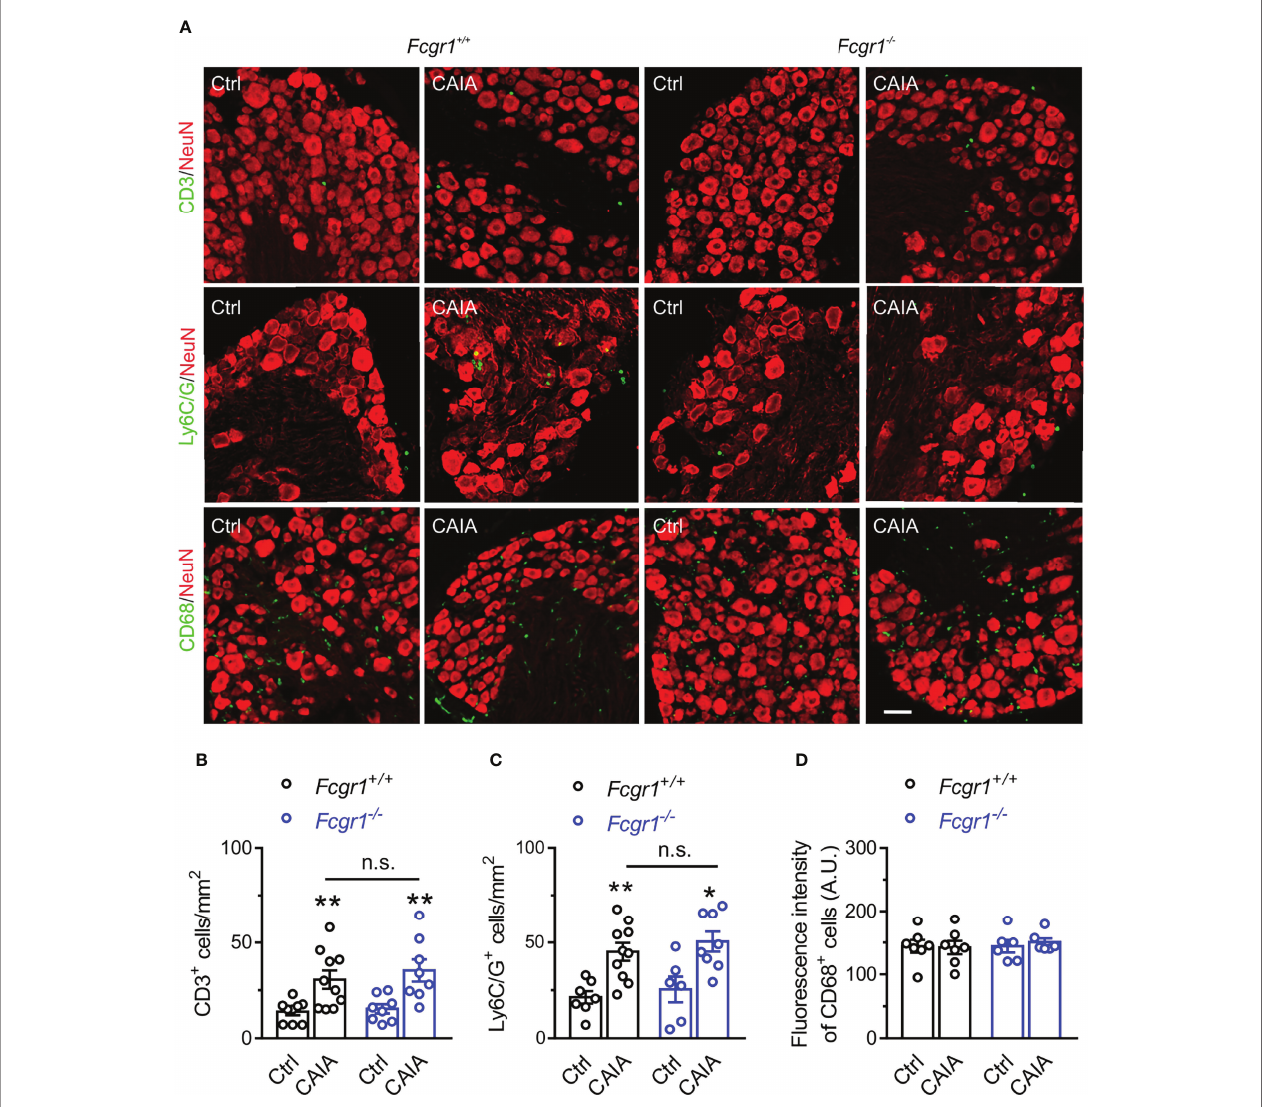
FIGURE 7 | Fc g RI does not contribute to immune cell in fi ltration in mouse DRG in the late phase of CAIA. (A) Representative image of mouse DRG sections from Fcgr1 +/+ and Fcgr1 -/- mice on day 56 after CAIA. DRG sections were stained for CD3, Ly6C/G, CD68 and NeuN. Scale bar, 50 m m. (B – D) Quanti fi cation showed an increase in the number of CD3 + ( B ; n = 8-10 mice/group) and Ly6C/G + ( C ; n = 6-10 mice/group) cells per unit area but not the mean fl uorescent intensity of CD68 + ( D ; n = 6-7 mice/group) per unit area in the DRG of either genotype on day 56 after CAIA induction. Yet, no obvious differences in CD3 + or Ly6C/G + cell in fi ltration were observed between genotypes. *p < 0.05, **p < 0.01 versus Ctrl, two-way ANOVA followed by Bonferroni post hoc test. n.s., not signi fi